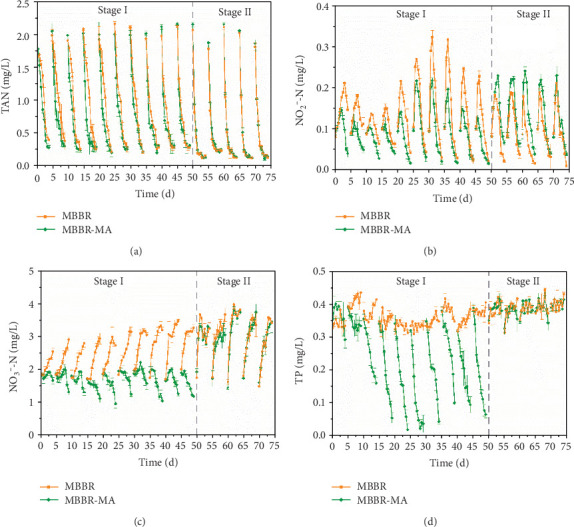
The concentrations of TAN (a), NO2-N (b), NO3−-N (c), and TP (d) dynamics in both MBBA and MBBA-MA.